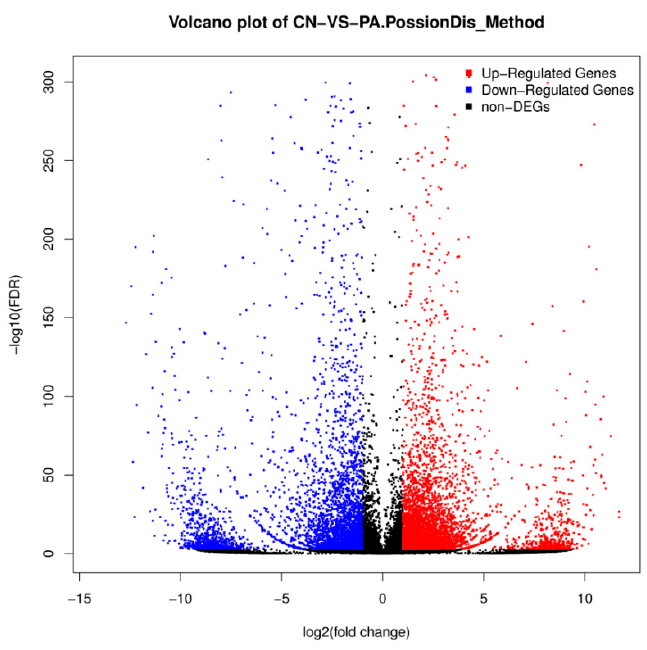
Figure 3. Volcano plot of differentially expressed genes (DEGs) between the control (CN) and PA-treated group. Blue, red and black points represent down regulated genes, up regulated genes and non-differential expression genes, respectively. FDR: false discovery rate.